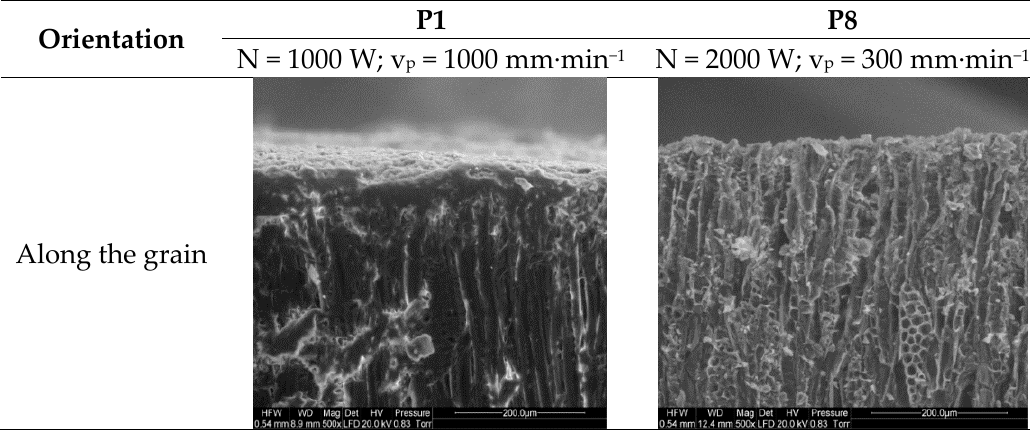
Figure 9. Cellular structure of poplar wood after laser cutting in trials P1 and P3.